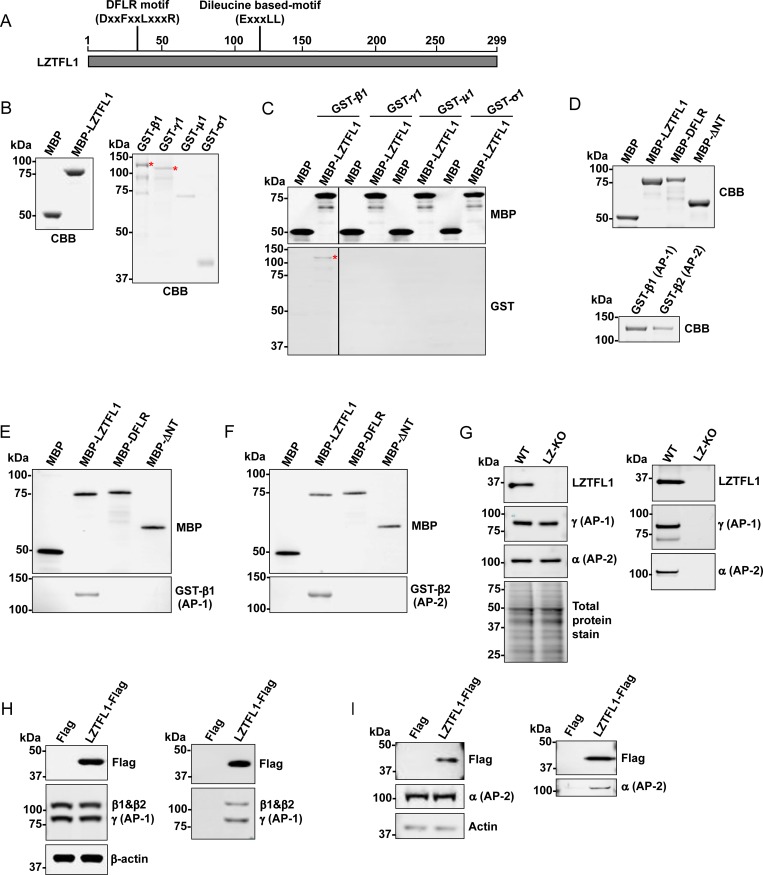
LZTFL1 directly binds to β1 subunit of AP-1 and β2 subunit of AP-2 in vitro.(A) Schematic representation of potential protein-binding domains of LZTFL1. (B) Purified LZTFL1 fused with maltose-binding protein (MBP, left) as well as individual subunits of AP-1 complex (β1, γ, μ1, and σ1) fused with glutathione S-transferase (GST, right) were visualized by Coomassie Brilliant Blue (CBB) staining. Full-length GST-β1 and GST-γ are indicated with red asterisks. (C) Purified MBP or MBP-LZTFL1 was incubated with each of the purified GST-fused subunits of the AP-1 complex (β1, γ, μ1, and σ1), and the LZTFL1-bound subunit was purified by amylose resin and analyzed by western blotting using anti-MBP and anti-GST antibodies. The GST-β1 band is indicated with a red asterisk. (D, top) Purified wild-type LZTFL1 and LZTFL1 mutants fused with MBP and (D, bottom) β1 and β2 subunits of AP-1 and AP-2 respectively fused with GST were visualized by CBB staining. Purified MBP, MBP-LZTFL1, or mutants were incubated with (E) GST-β1 (AP-1) or (F) GST-β2 (AP-2) and pulled-down proteins were analyzed by western blotting using anti-MBP and anti-GST antibodies. (G) Brain tissue lysate from wild-type and Lztfl1-knockout mice was analyzed by western blotting using anti-LZTFL1 antibody, anti-γ subunit of AP-1 antibody, anti-α subunit of AP-2 antibody, and REVERT staining for total protein (left). Lysate was immunoprecipitated with anti-LZTFL1-conjugated beads. The LZTFL1-interacting proteins were eluted by NuPAGE LDS buffer and analyzed by western blotting using anti-LZTFL1, anti-γ subunit of AP-1, and anti-α subunit of AP-2 antibodies (right). (H, left) Lysate from HEK293FT cells transiently expressing FLAG or LZTFL1-FLAG was analyzed by western blotting using anti-FLAG, anti-β1 subunit and anti-γ subunit of AP-1, and anti-β-actin antibodies or (I, left) anti-FLAG, anti-α subunit of AP-2, and anti-actin antibodies. (H, right) Cell lysate was immunoprecipitated with anti-FLAG M2 magnetic beads. The LZTFL1-interacting proteins were eluted by 3X FLAG peptide and analyzed by western blotting using anti-FLAG, anti-β1 subunit of AP-1, and anti-γ subunit of AP-1 antibodies or (I, right) anti-FLAG and anti-α subunit of AP-2 antibodies.